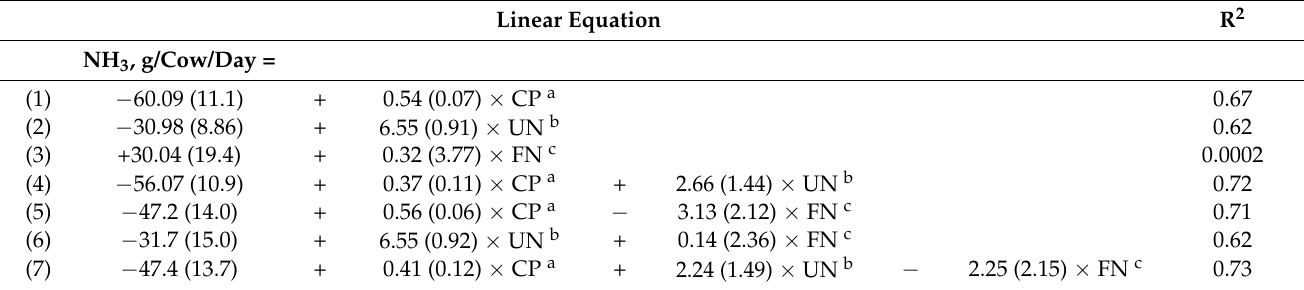
Table 5. Linear regression of NH 3 emissions from slurry from lactating cows with dietary CP level, total urinary nitrogen (UN), and faeces N (FN). Linear Equation R